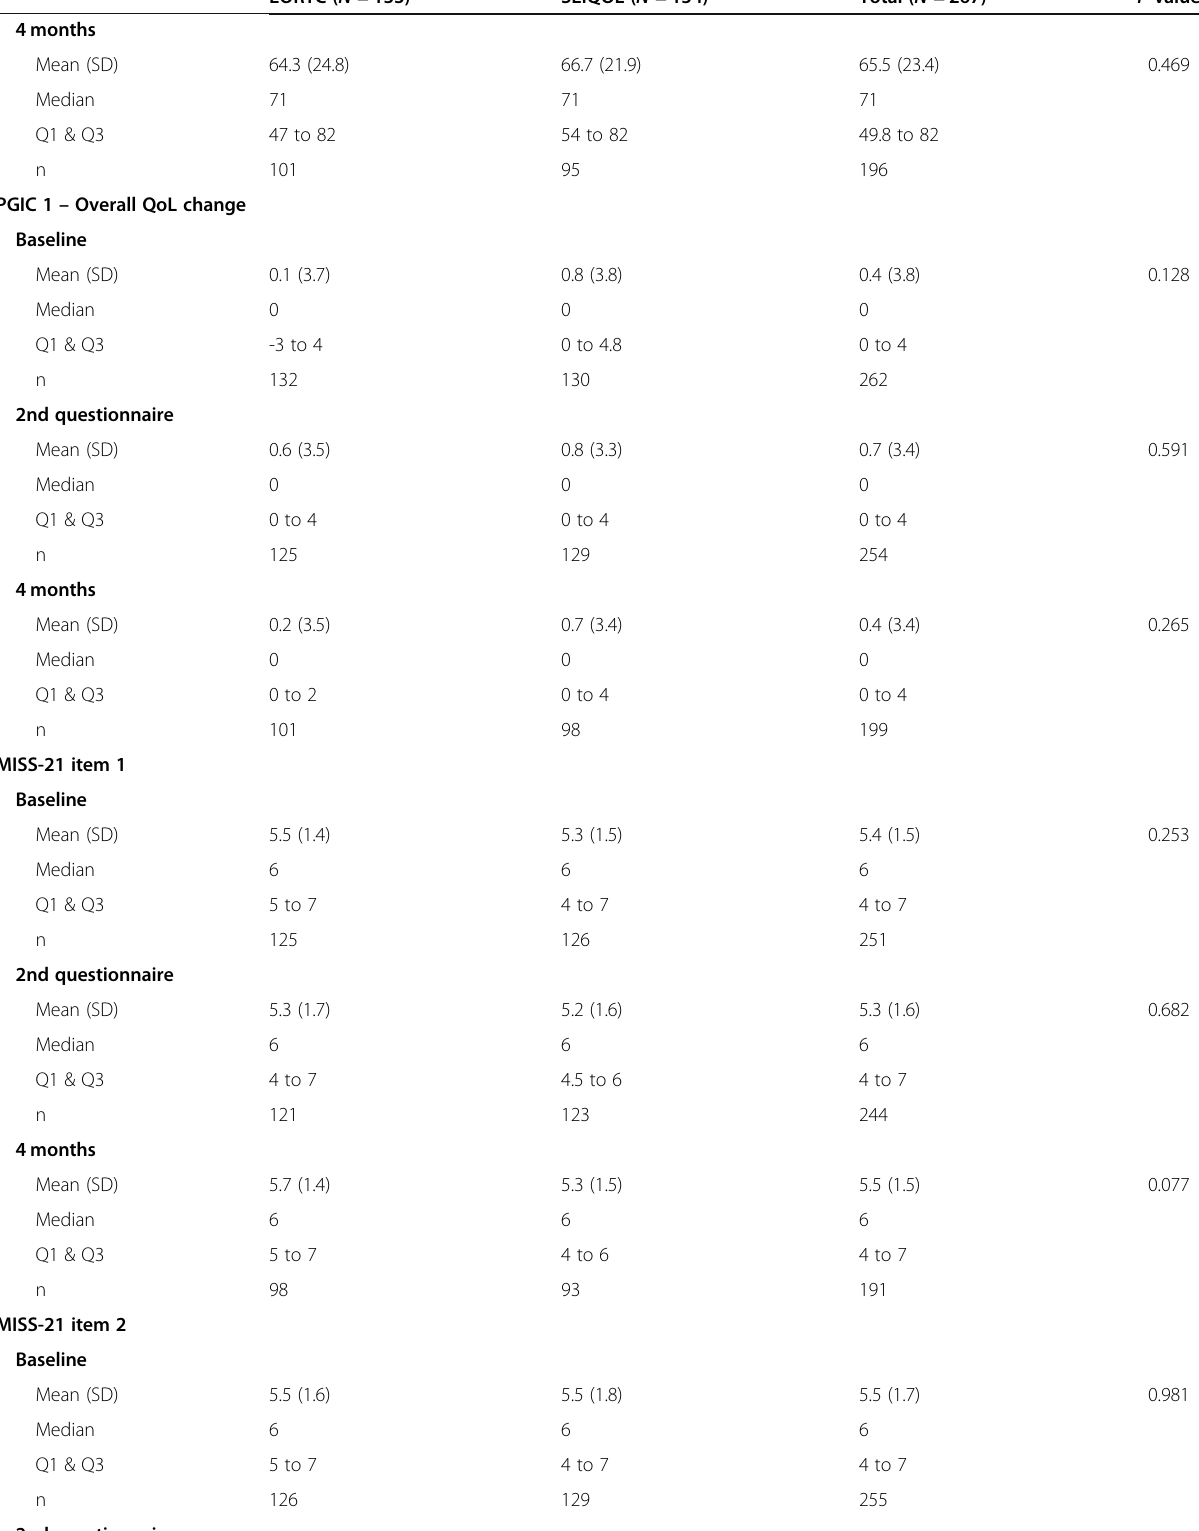
Table 2 Outcomes a over time for analyzed patients